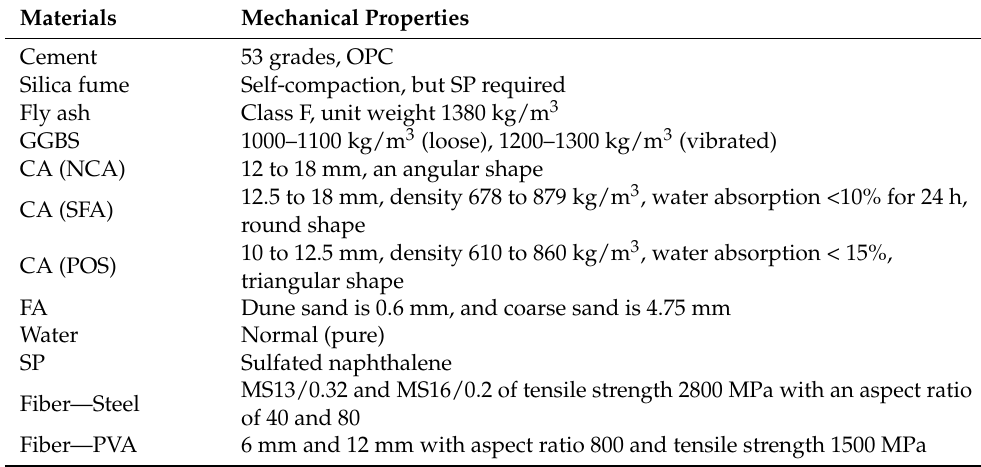
Table 1. Mechanical properties of